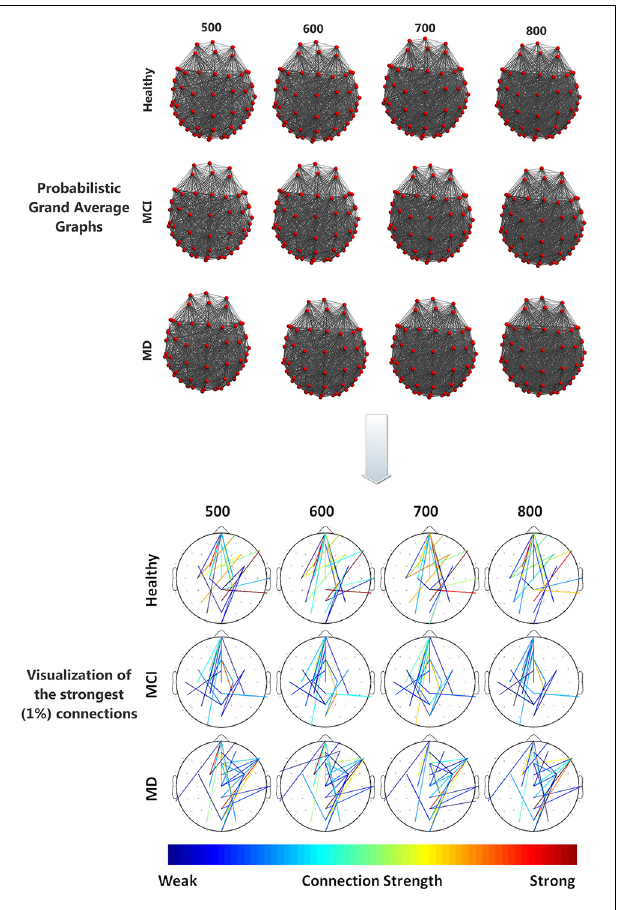
FIGURE 2 | (Top) Visualization of grand average brain graphs for each one of the three study groups (Healthy, MCI, MD) and for each edge density value (500, 600, 700, 800). (Bottom) visualization of the strongest (1%) network connections and their (edge) strengths, depicted through a colorbar.